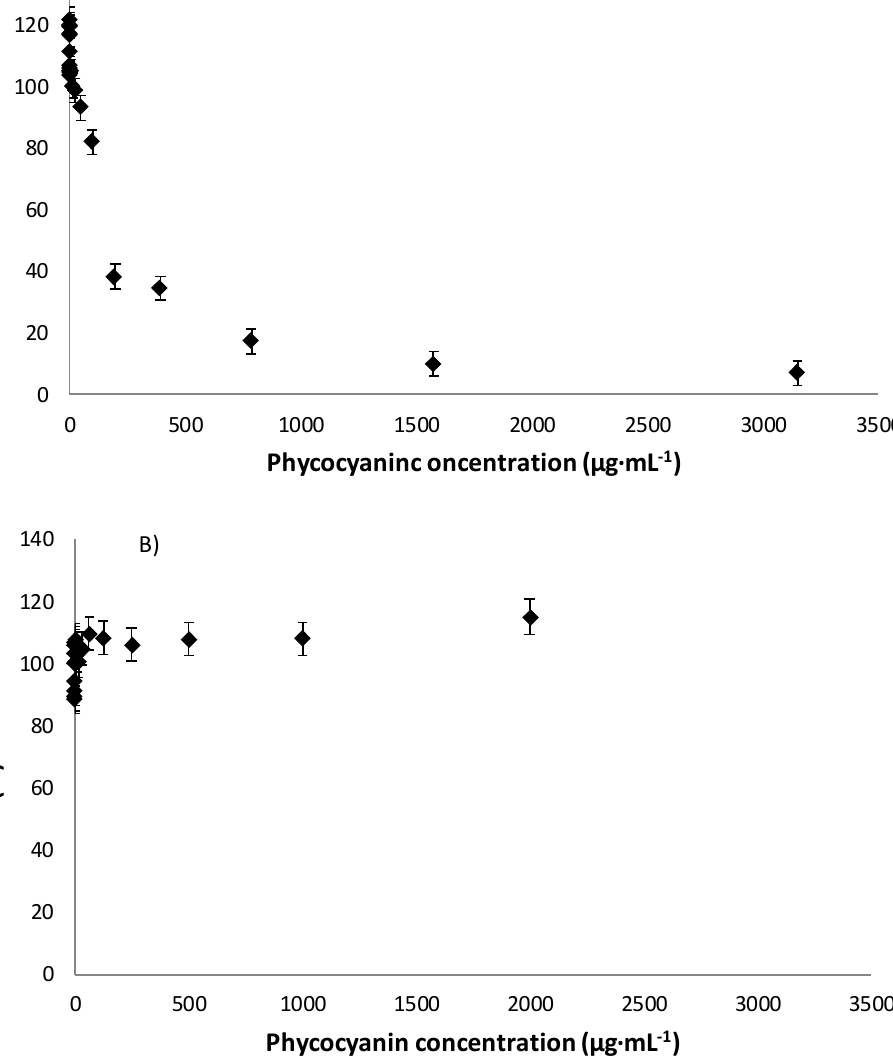
Figure 4. Survival of the HGF-1 cell line as a function of the C-phycocyanin concentration for the obtained extract ( A ) and Sigma’s 99.9% purity of phycocyanin ( B ).